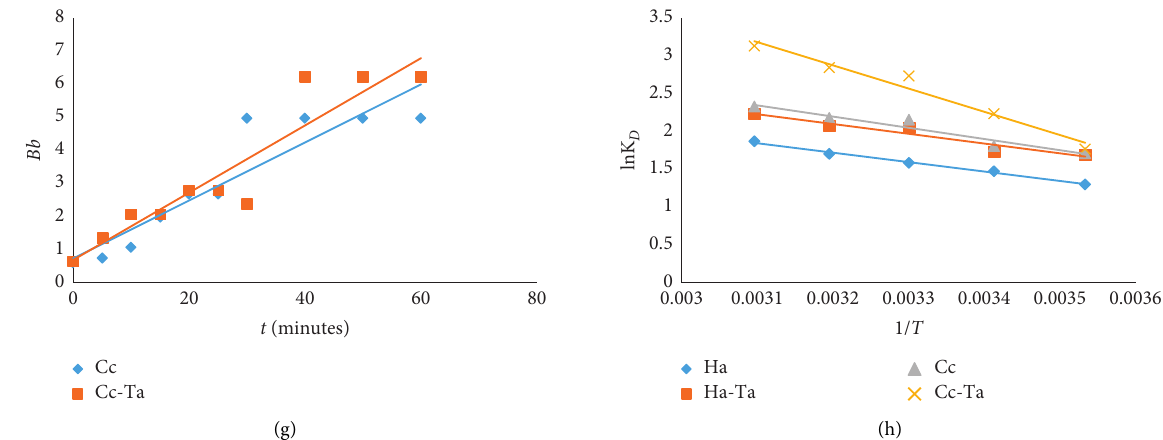
Figure 6: (a) Pseudo-first-order kinetics, (b) pseudo-second-order kinetics, (c) Elovich plots, (d) Webber–Morris plots for Ha and Ha-Ta, (e)Webber–Morris plots for Cc and Cc-Ta, (f) Boyd’s plots for Ha and Ha-Ta, (g) Boyd’s plots for Cc and Cc-Ta, and (h) thermodynamic parameters of BG dye.